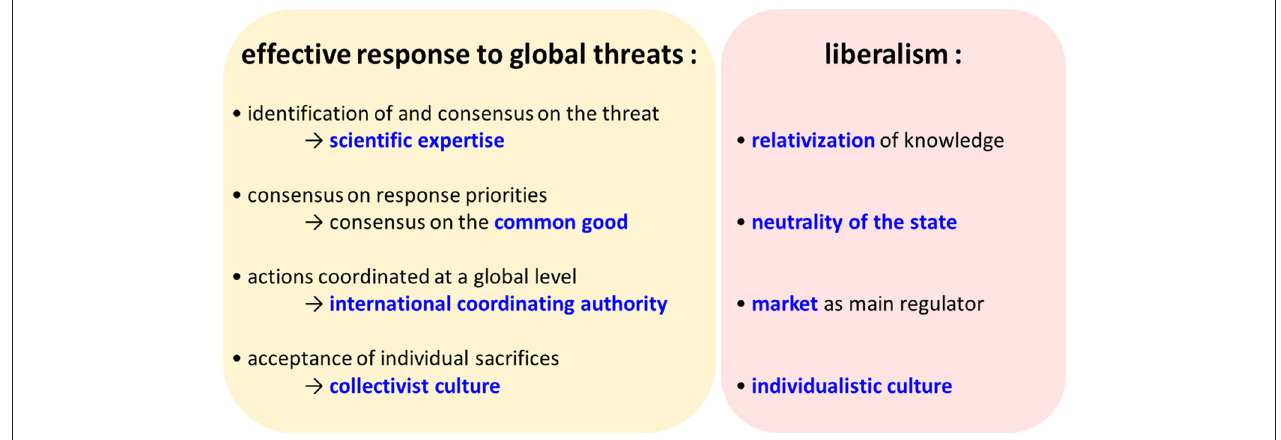
FIGURE 4 | Structural weaknesses of liberalism in the face of global